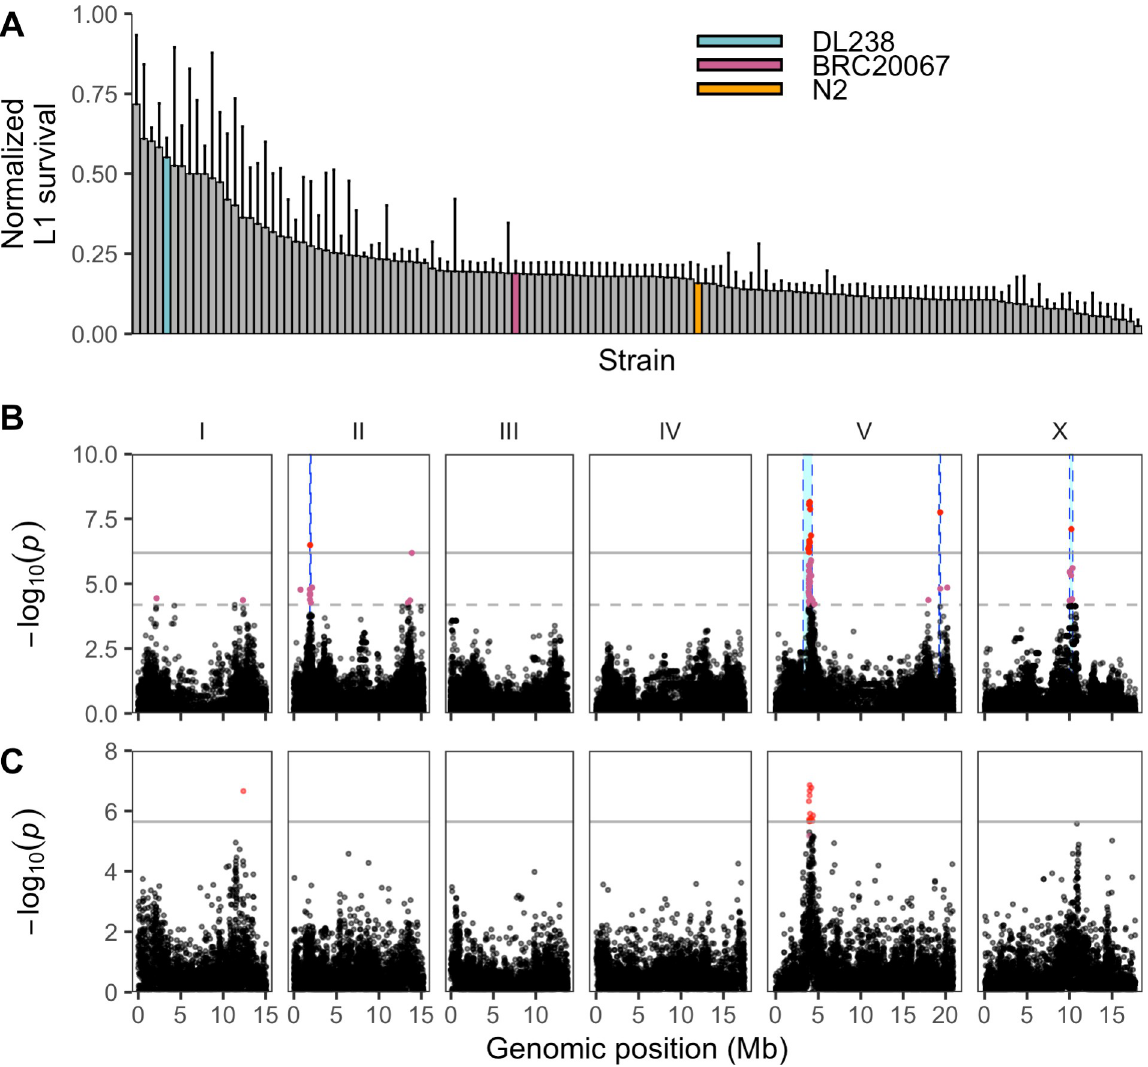
Fig 2. Multiple QTL are associated with variable propionate sensitivities among C . elegans strains. (A) Normalized L1 survival in the presence of 100 mM propionate for 133 wild C . elegans strains. L1 survival percentages were normalized by dividing each strain measurement by the maximum L1 survival percentage of all strains. Error bars show the standard deviation of replicate strain measurements. The reference strain N2 (orange) and the two strains discussed throughout this work DL238 (blue) and BRC20067 (pink) are colored. (B) Manhattan plot from marker-based GWA mapping for the normalized L1 survival percentage after propionate exposure. Each point represents an SNV that is present in at least 5% of the assayed wild population. The genomic position in Mb, separated by chromosome, is plotted on the x-axis and the -log10(p) for each SNV is plotted on the y-axis. SNVs are colored red if they pass the genome-wide Bonferroni-corrected significance (BF) threshold, which is denoted by the gray horizontal line. SNVs are colored pink if they pass the genome-wide Eigen-decomposition significance threshold, which is denoted by the dotted gray horizontal line. The genomic regions of interest surrounding the QTL that pass the BF threshold are indicated in cyan. (C) Manhattan plot from gene-based GWA mapping for L1 survival after propionate exposure. Each point represents a gene and is colored red if it passes the genome-wide BF threshold (gray line). Points are colored pink if they are significant after 1000 permutations. The genomic position in Mb, separated by chromosome, is plotted on the x-axis and the -log10(p) for each gene is plotted on the y-axis.